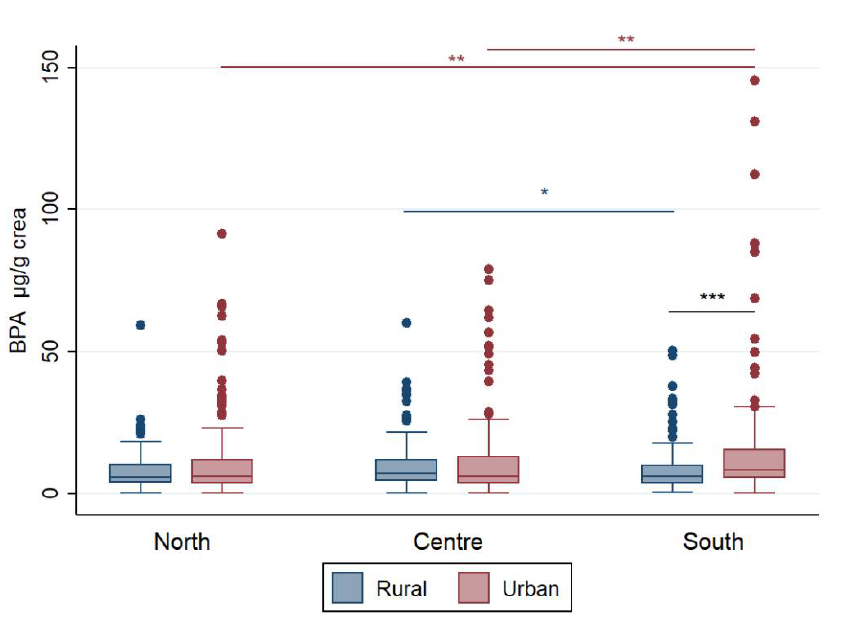
Figure 1. Box plots for BPA levels in urine samples of Italian children stratified by macro-area and area and normalized to urine creatinine content (µg/g). Outliers above 150 µg/g were excluded from the graph to improve box plot visibility. Asterisks indicate the level of significance: * p < 0.05, ** p < 0.01, *** p < 0.001.